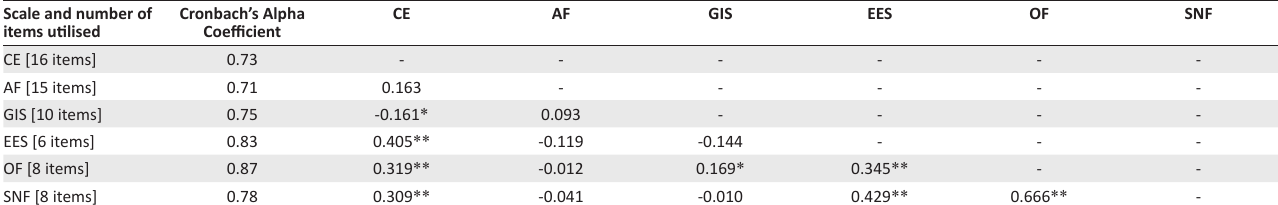
TABLE 2: Pearson correlation analysis results and Cronbach’s Alpha coefficients. Scale and number of items utilised